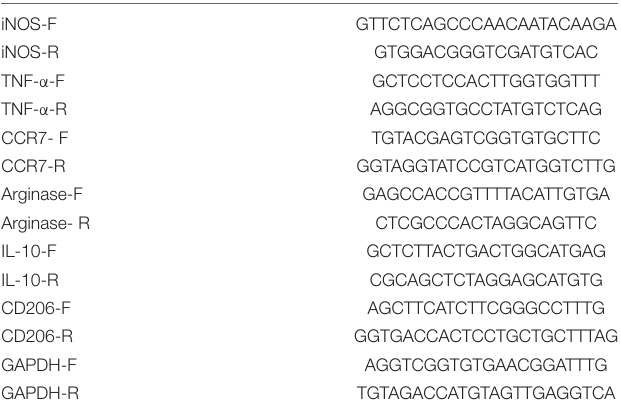
TABLE 1 | Primers for qPCR. (5 (cid:48) –3 (cid:48) ).